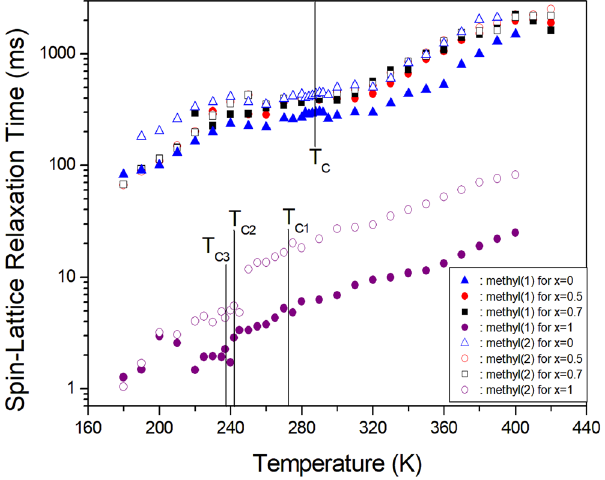
Figure 7. Temperature dependences of the 13 C spin-lattice relaxation time in the rotating frame T 1 ρ for [N(CH